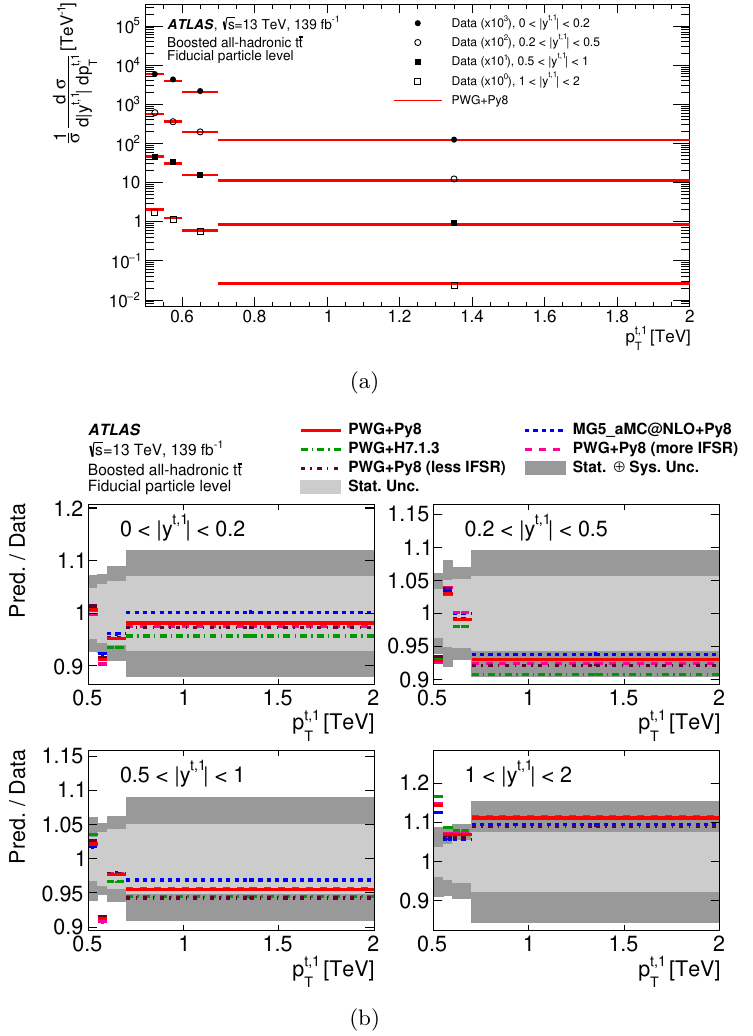
Figure 14 . (a) Normalized particle-level fiducial phase-space double-differential cross-sections as a function of the absolute value of the rapidity and p T of the leading top-quark jet, compared with the Powheg+Pythia 8 calculation. Data points are placed at the centre of each bin and the Powheg+Pythia 8 calculation is indicated by solid lines. The measurement and the prediction are normalized by the factors shown in parentheses to aid visibility. (b) The ratios of various MC calculations to the normalized particle-level fiducial phase-space differential cross-sections. The dark and light grey bands indicate the total uncertainty and the statistical uncertainty, respectively, of the data in each